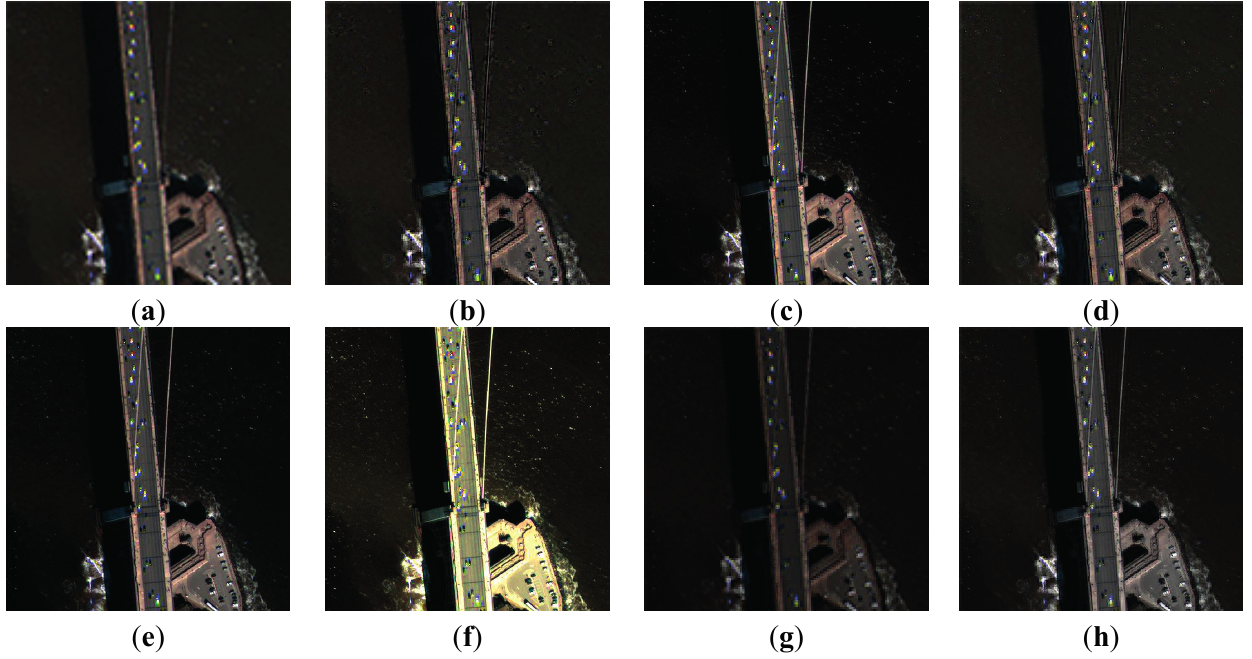
Figure 15. ( a ) Multispectral Image of bridge image. ( b ) BEMD fusion image. ( c ) IHS fusion image. ( d ) Wavelet fusion image. ( e ) PCA fusion image. ( f ) Brovey fusion image. ( g ) Gaussian high-pass spatial filter fused image. ( h ) Laplacian pyramidal decomposition